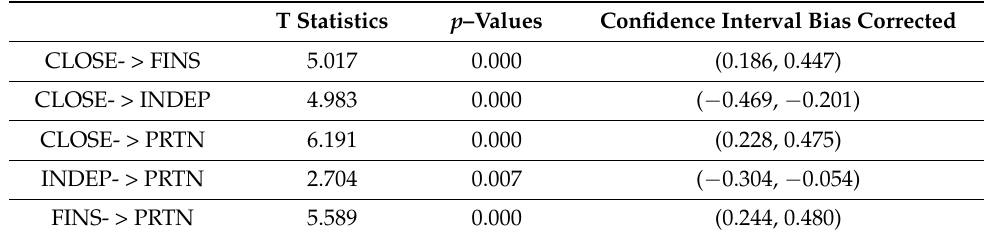
Table 6. Bootstrapping